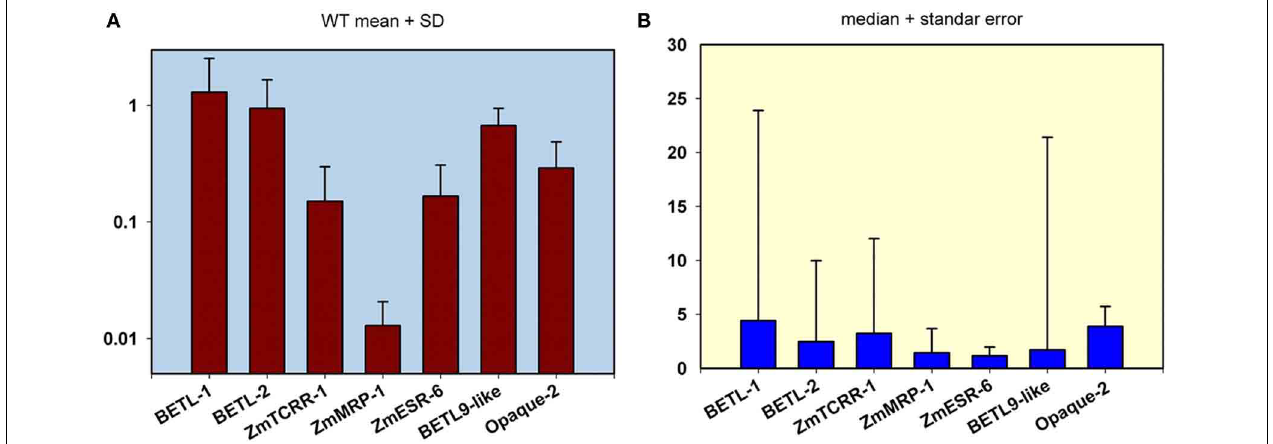
FIGURE 3 | Transcript level quantification in the wild type (WT) and mutant kernels from the 101 mutant lines analyzed in this study. (A) Expression analyses in WT kernels. The mean value and standard deviation from the analysis of the 101WT samples are indicated for the 7 markers used in this study. The scale in the Y axis is logarithmic.